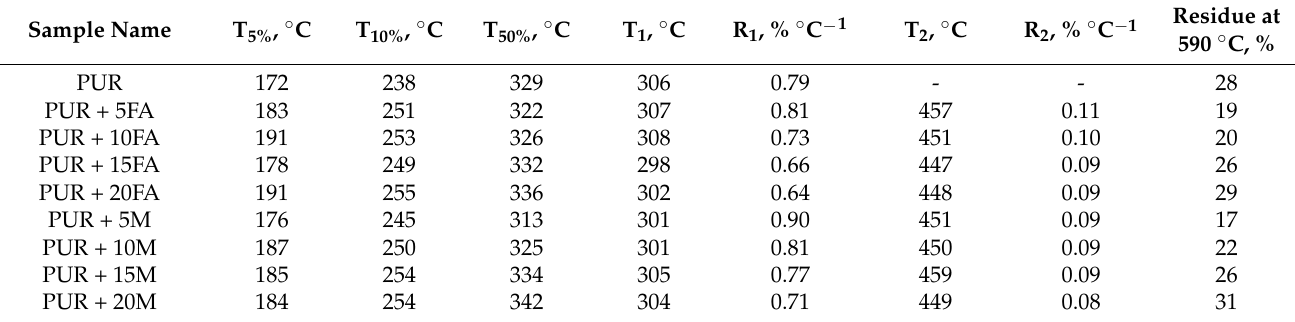
Figure 7. TGA and DTG curves of unmodified PUR foam and composite materials containing FA ( a ), and M ( b ). The corresponding thermal parameters are marked in Table 7. These were: T 5% - which represented initial degradation temperature corresponding to 5% weight loss; T 10% and T 50% -temperatures at 10 and 50% weight loss, respectively; T 1 and T 2 -temperatures with maximum degradation rates in first and second degradation stage, respectively (as the DTG peaks maximum); and R 1 and R 2 -the maximum rate of degradation (% °C −1 ) in first and second degradation stage, respectively. Table 7. Characteristics of thermal degradation of the PUR foams.